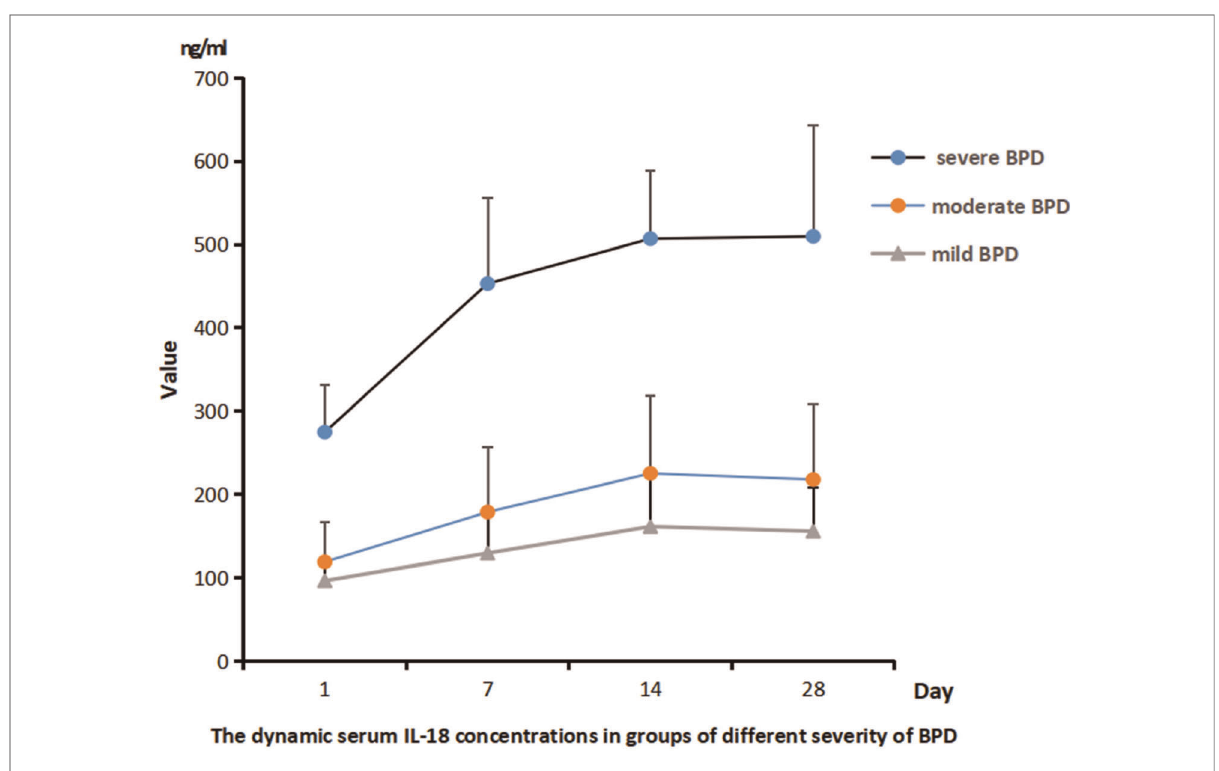
FIGURE 5 The dynamic serum IL-18 concentrations in groups with different severity of BPD (ng/ml).